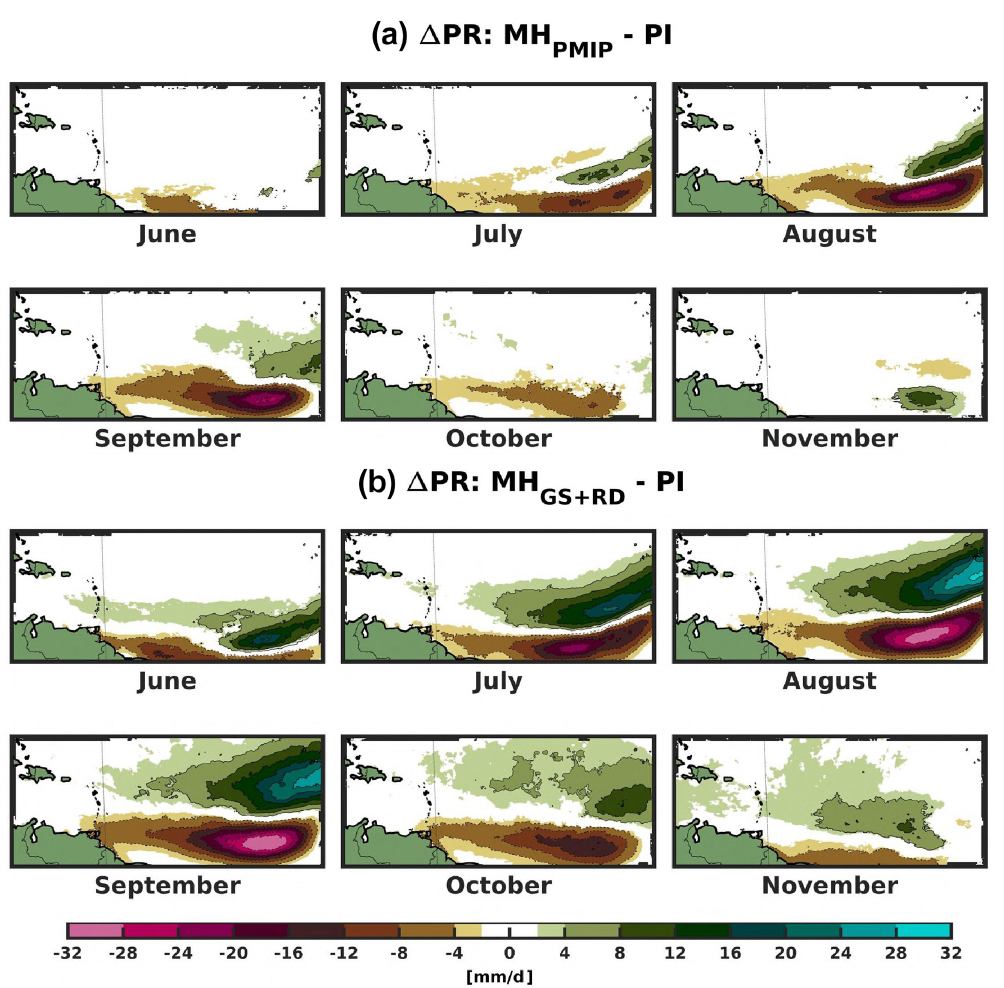
Figure A4. Monthly mean climatological changes in precipitation for (a) MH PMIP and (b) MH GS + RD relative to PI in the domain of 5– 23 ◦ N, 23–75 ◦ W. Only values that are significantly different at the 5% level using a local (grid-point) t test are shaded. The contour lines follow the color-bar scale (dashed, negative anomalies; solid, positive anomalies); the 0 line is omitted for clarity.